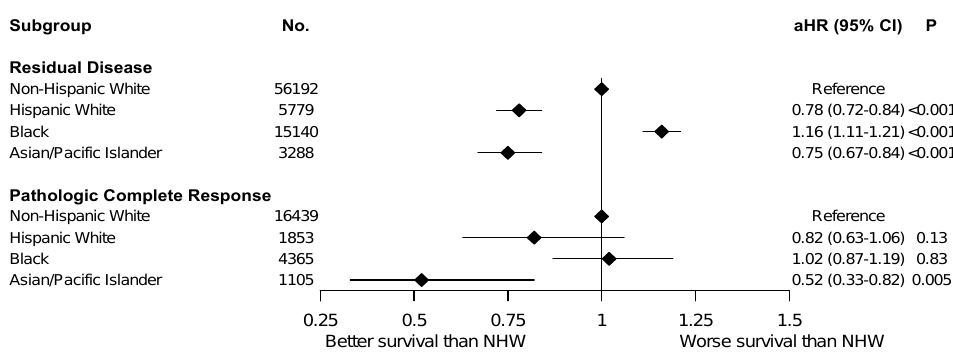
5 of 9 Figure 2. Logistic regression multivariable analysis for pathologic complete response stratified by tumor receptor subtypes and racial groups. No.: number; aOR: adjusted odds ratio; 95% CI: 95% confidence interval; HR: hormone receptor; HER2: human epidermal growth factor receptor 2; NHW: non-Hispanic White. Cox MVA was adjusted for age, facility volume, insurance, LVSI, facility type, in- come level, CDS, histology, grade, T and N staging, tumor receptor status, surgery, surgi- cal margin, postoperative readmission, chemotherapy, endocrine therapy, immunother- apy, and time interval between diagnosis and chemotherapy. In this MVA model, pCR was associated with improved OS (adjusted hazards ratio (aHR) 0.31, 95% CI 0.29–0.33, p < 0.001). When compared to NHW women, HW (aHR 0.79, 95% CI 0.73–0.85, p < 0.001) and API (aHR 0.73, 95% CI 0.65–0.81, p < 0.001) women had improved OS, while Black women (aHR 1.15, 95% CI 1.10–1.20, p < 0.001) had worse OS. The interaction between race and tumor response was statistically significant (interaction p = 0.001), while its inter-